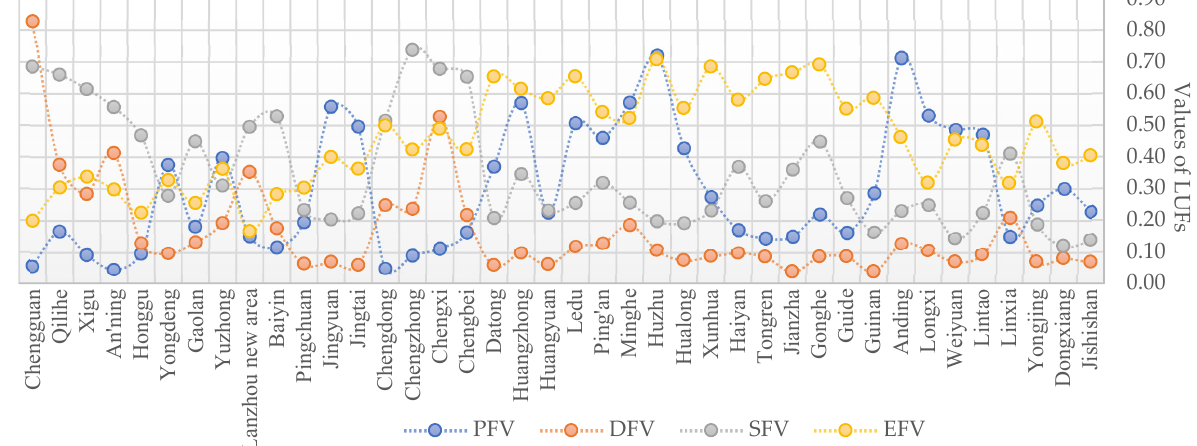
Figure 5. Values of LUFs of 40 counties and districts in LXR.